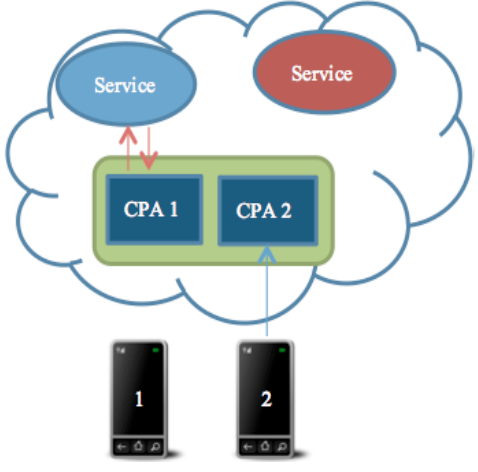
Figure 1. The mobile cloud provides